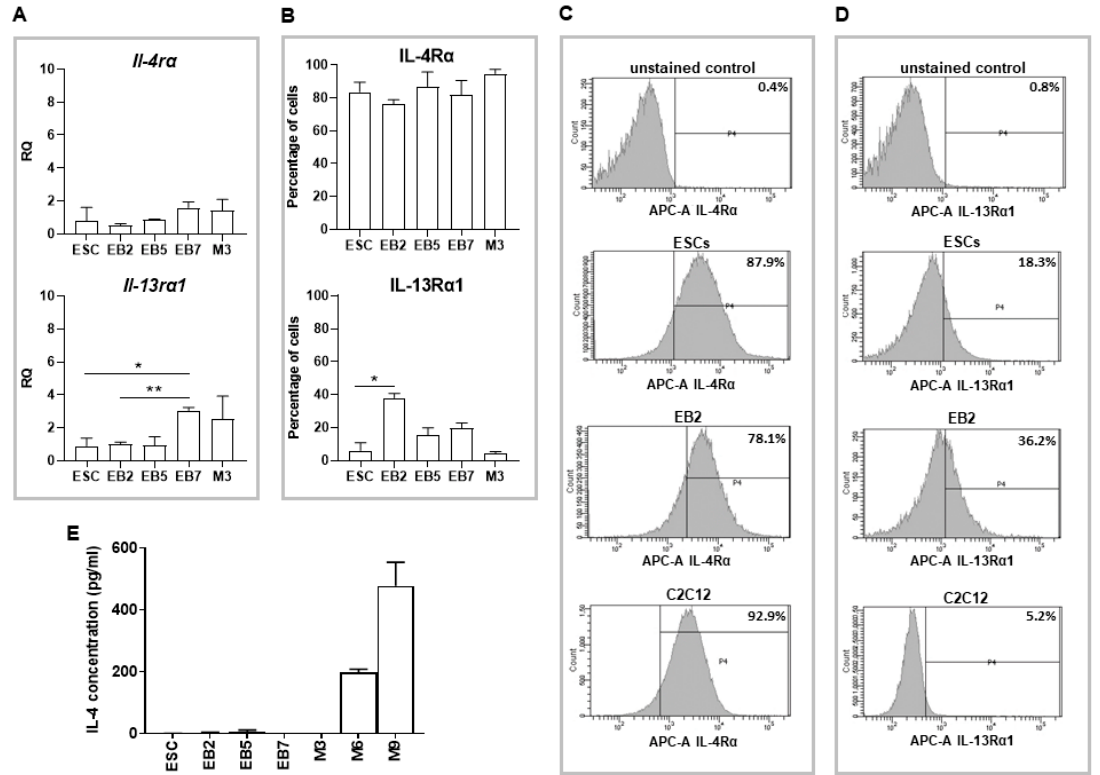
Figure 3. Analysis of expression of IL-4 and IL-4 type II receptor in ESCs differentiating in the EBs. ( A ) Expression of Il-4r α and Il-13r α 1 in undifferentiated ESCs, ESCs differentiating in EBs for 2 (EB2), 5 (EB5) and 7 (EB7) days, and proliferating C2C12 myoblasts at day 3 of the culture (M3). β -actin was used as a reference gene. RQ = 1 for the expression level detected in 13.5-day-old mouse embryo. Data are represented as the means of three independent experiments with standard deviations; * p < 0.05; ** p < 0.01. ( B ) Percentage of undifferentiated ESCs, cells obtained after disaggregation of EB2, EB5, and EB7 and proliferating C2C12 myoblasts synthesizing IL-4R α or IL-13R α 1, analyzed with flow cytometry. * p < 0.05. ( C , D ) Representative histograms presenting percentage of cells synthesizing IL-4R α ( C ) or IL-13R α 1 ( D ) in unstained ESCs (negative control, upper) and stained populations of either ESCs, EB2-derived cells, and C2C12 myoblasts. ( E ) IL-4 concentration in the medium collected from ESCs, ESCs differentiating in EBs, and C2C12 myoblasts. Data are represented as means of three independent experiments with standard deviations.